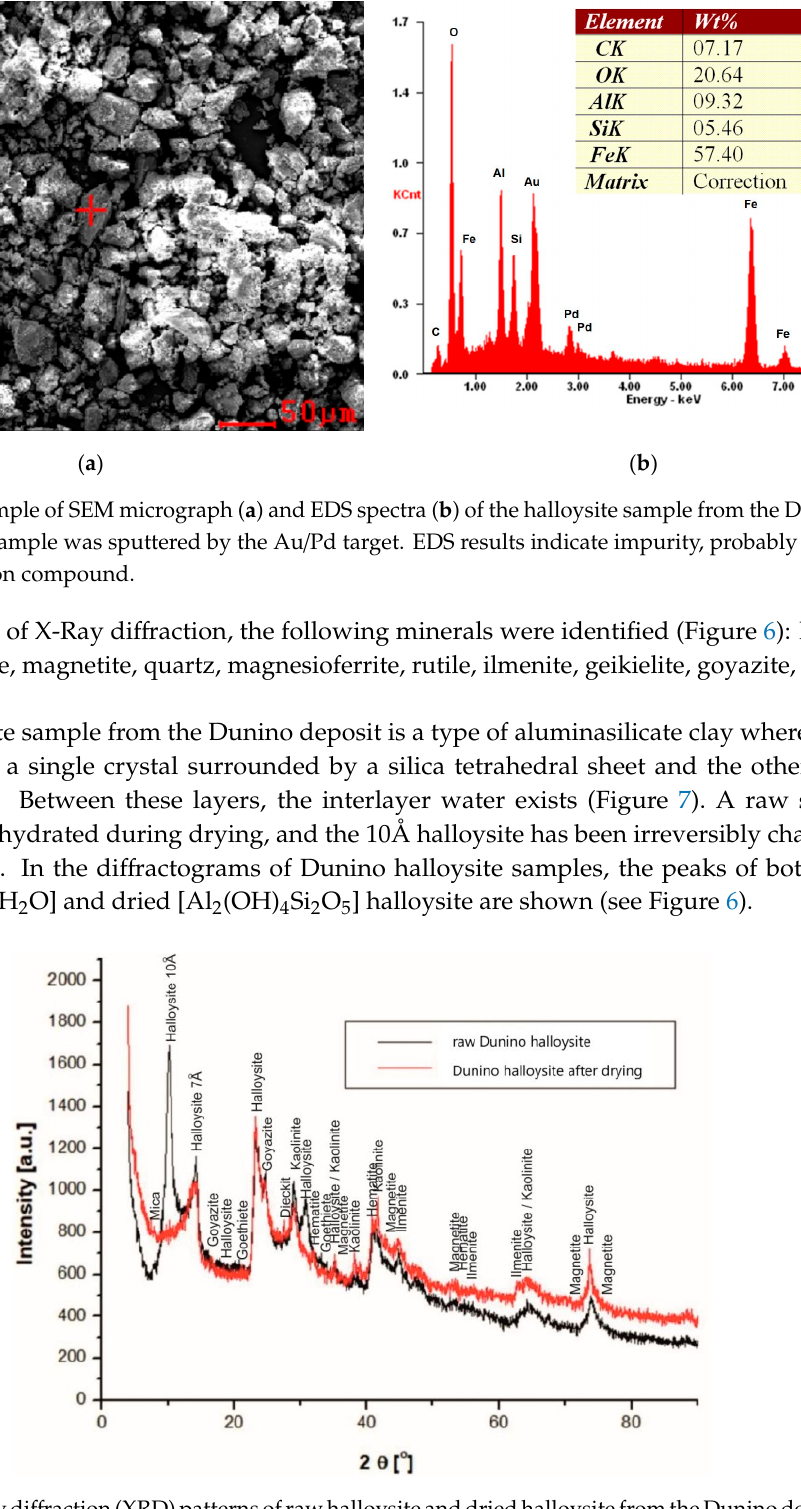
Figure 4. Example of SEM micrograph ( a ) and EDS spectra ( b ) of a halloysite sample from the Dunino deposit. The sample was sputtered by an Au/Pd target.